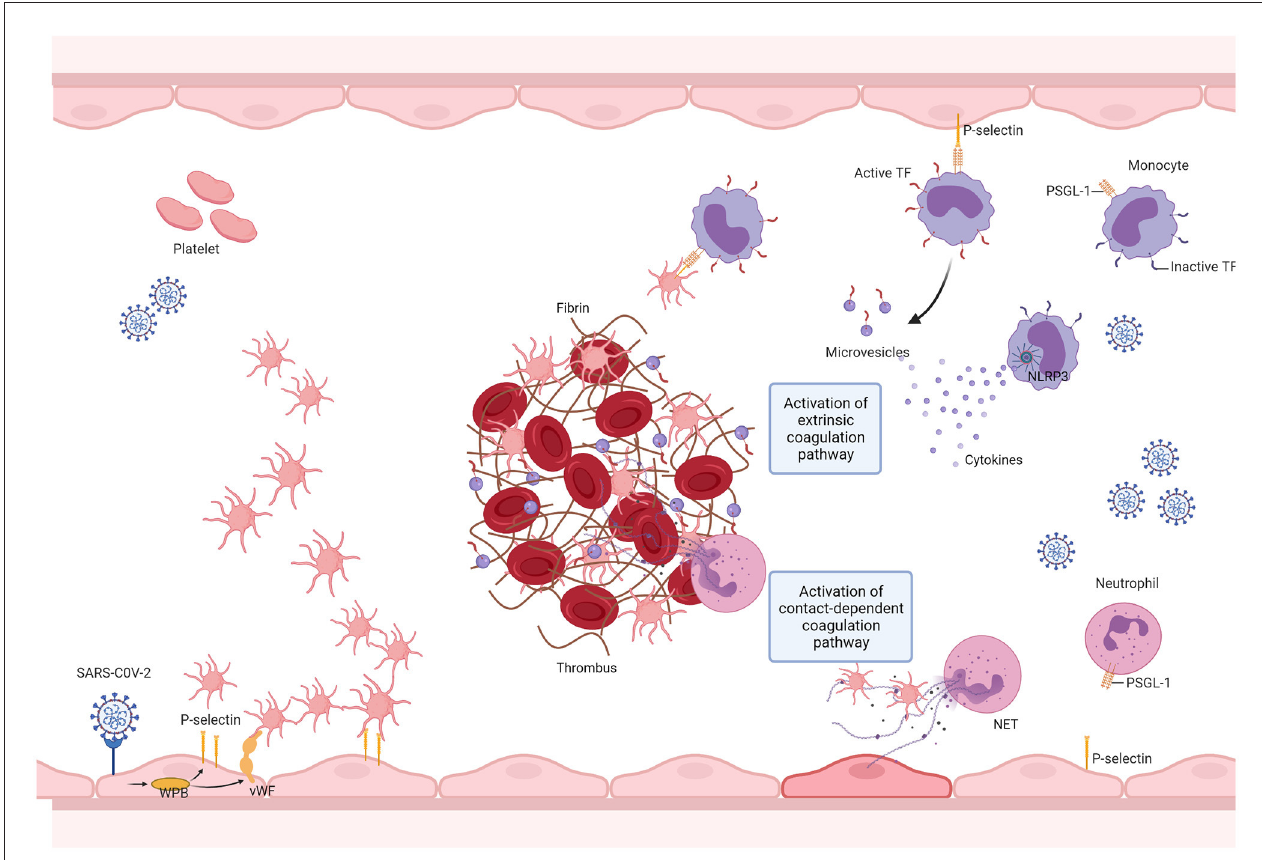
FIGURE 2 | SARS-CoV-2 promotes thrombus formation by engaging multiple vascular cells. The SARS-CoV-2 infection triggers the innate immune response, resulting in the activation of monocytes, which in turn elicit a pro-inflammatory cytokine storm. This results in neutrophil recruitment, endothelial cell, and platelet activation. Endothelial cell activation is followed by the release of von Willebrand factor (VWF) and adhesion molecules, leading to platelet recruitment and activation. Platelet activation results in the exposure of new receptors, including glycoprotein α IIb β 3, which enables fibrinogen binding and allows platelet aggregation, and the translocation of P-selectin to the platelet surface, enabling the formation of platelet-monocyte and platelet-neutrophil aggregates. The interaction between platelets and monocytes and pro-inflammatory cytokines upregulate tissue factor (TF) expression and release it into microvesicles. TF then binds to coagulation factor VII (FVII), activating coagulation. SARS-CoV-2 infection may activate the NLRP3 inflammasome, leading to an increase in IL-1 β production and, therefore, resulting in a hypercoagulable state. SARS-CoV-2 mediated cytokine storm promotes sustained neutrophil recruitment and activation, culminating in neutrophil extracellular trap (NET) formation, which fosters thrombus formation. Created with